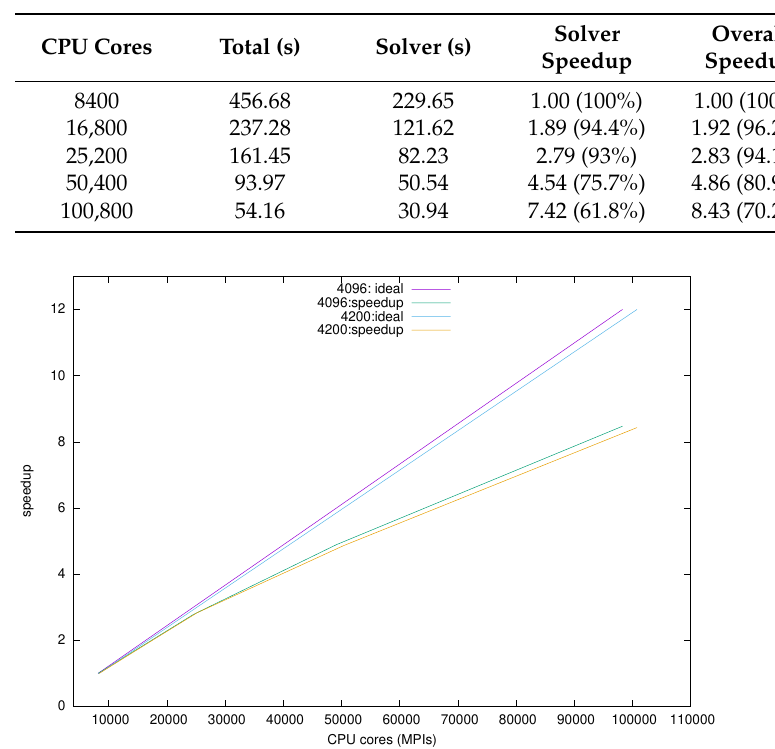
Table 17. Summary of Example 9.